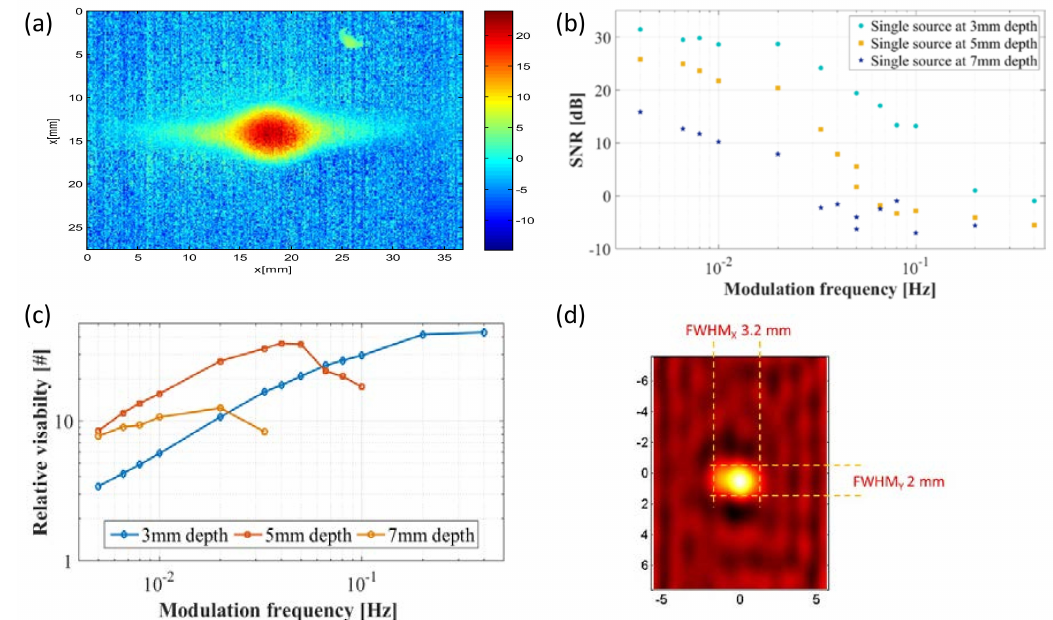
Figure 8. SNR analysis. ( a ) showing an example of the pixel-wise calculate SNR ( b ) Mean SNR in the image as a function of stimulation frequency and source depth; ( c ) Visibility measurements as a function of depth and modulation frequency. The figure shows the relative improvement in visibility compared to DC; ( d ) The reconstruction of a single heat source at 3 mm depth using Weiner deconvolution on the measured modulated surface